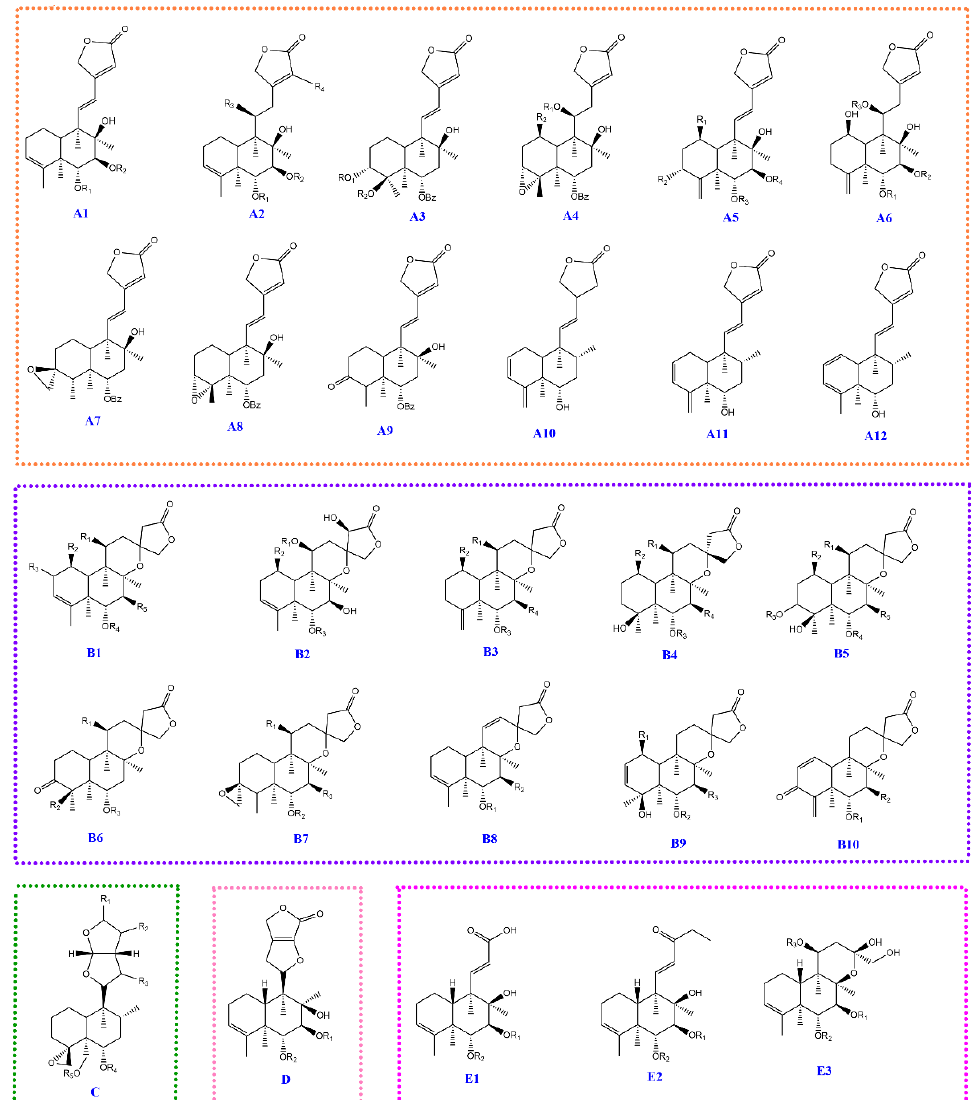
Figure 2. Twenty-seven subtypes of diterpenoids in Scutellaria barbata whose substituents mainly included the nicotinoyloxy, benzoyloxy, acetyl, hydroxyl C 4 H 7 O 2 , C 5 H 7 O 3 , C 7 H 11 O 4 , and C 9 H 15 O 4 groups.